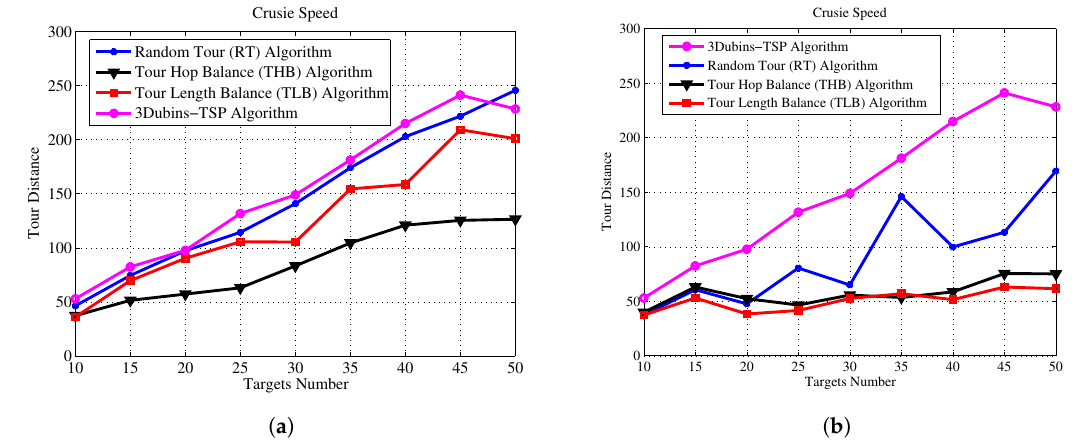
Figure 13. Cruise speed comparisons. ( a ) 2 AUVs; ( b ) 4 AUVs.